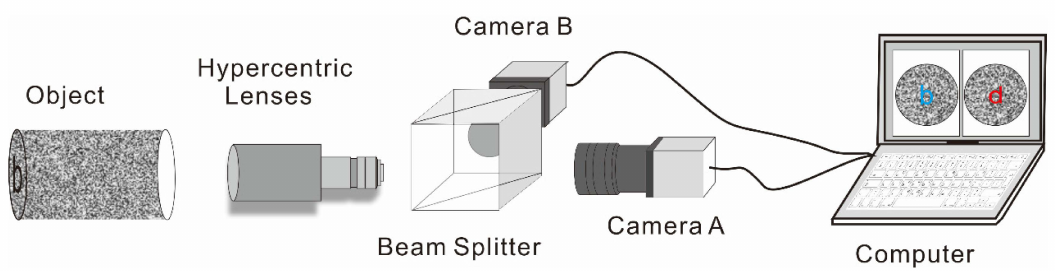
Figure 4. Schematic diagram of the coaxial dual camera with hypercentric lens.